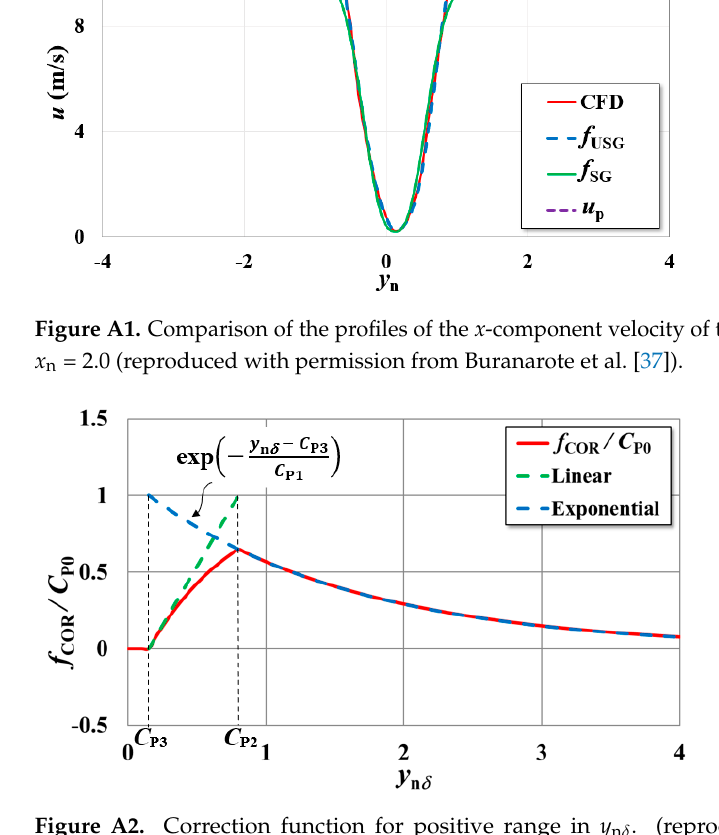
Figure A2. Correction function for positive range in y n δ . (reproduced with permission from Buranarote et al. [37]).